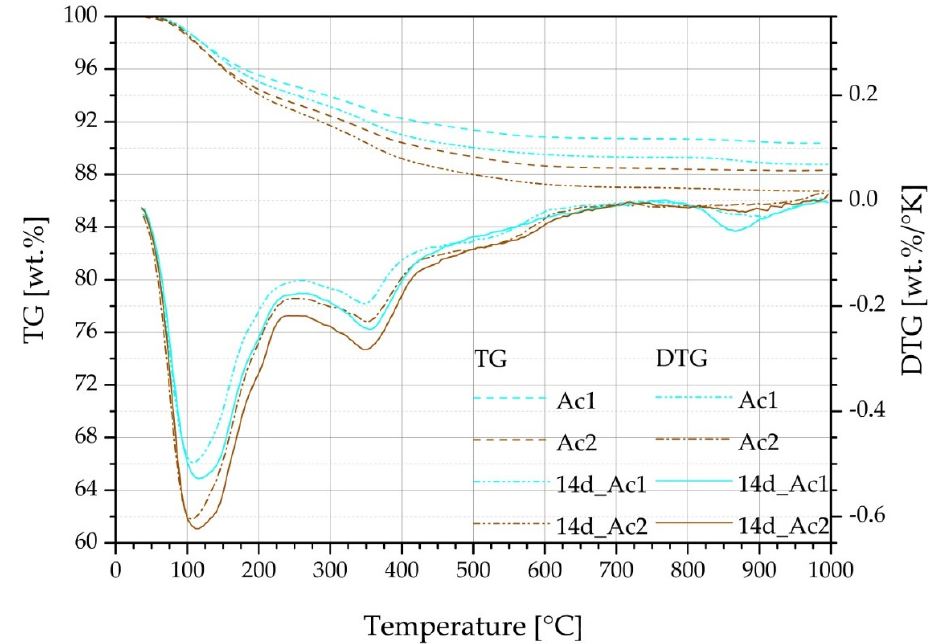
Figure 5. TG and DTG of the references (Ac1 and Ac2, without retarder) and its reactivations after 14 days of retardation with 1%R after a hydration period of 28 days.